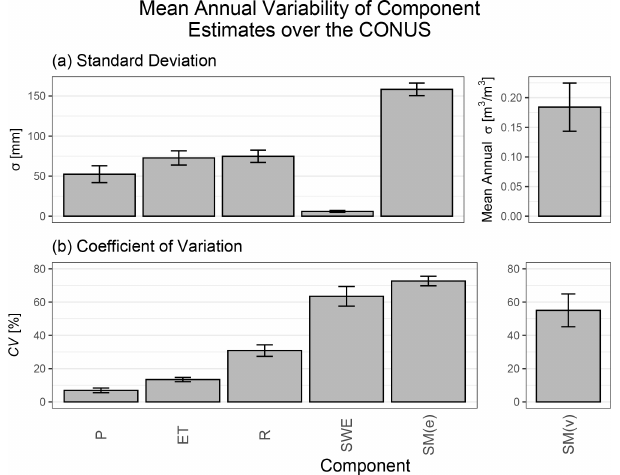
Figure 2. Mean annual (a) standard deviation ( σ ) and (b) coefficient of variation (CV) calculated between CONUS-extent modeled esti- mates of hydrologic components precipitation ( P ), evapotranspira- tion (ET), runoff ( R ), snow water equivalent (SWE), soil moisture in equivalent water depth (SM( e )), and soil moisture in volumetric water content (SM( v )). Whiskers on each bar represent the standard deviation of annual